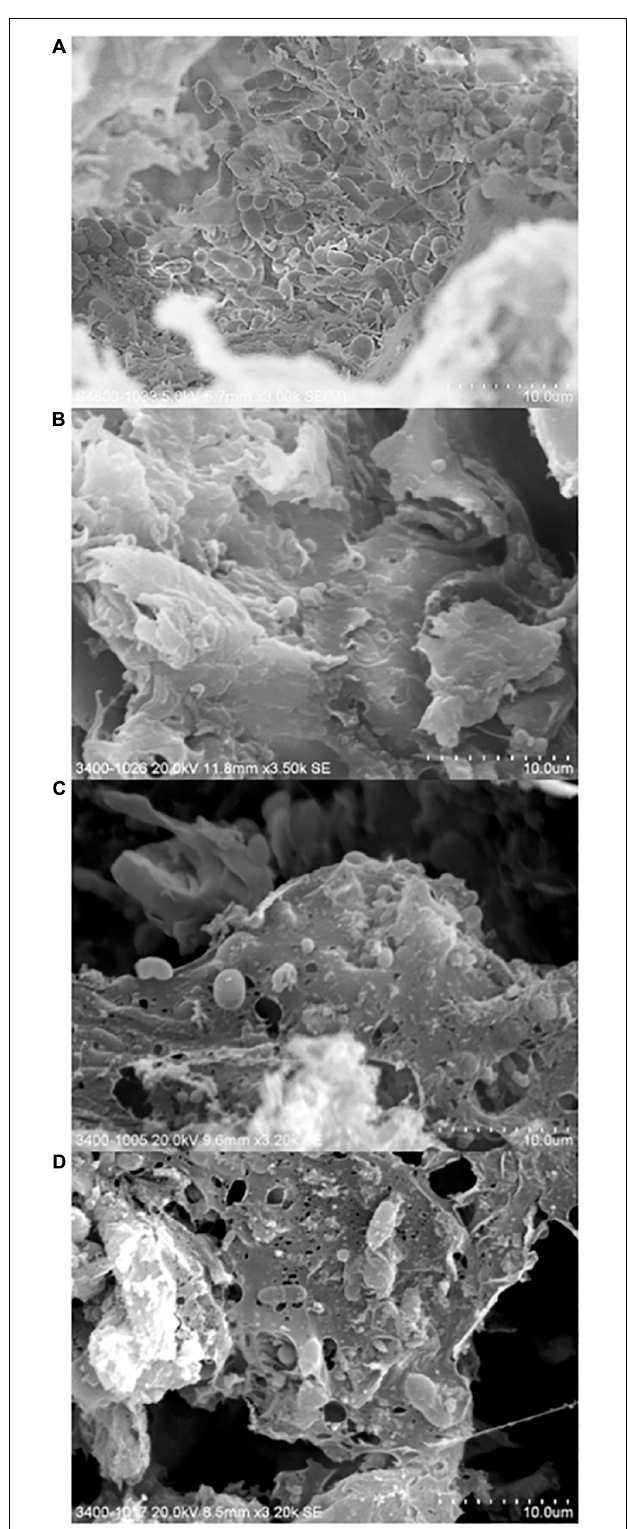
FIGURE 5 | Scanning electron micrographs of chopping board surface that underwent no hygienic treatment (A) , traditional scraping (B) , 0.024% sodium hypochlorite treatment (C) , and 0.1% sodium hypochlorite treatment (D) .